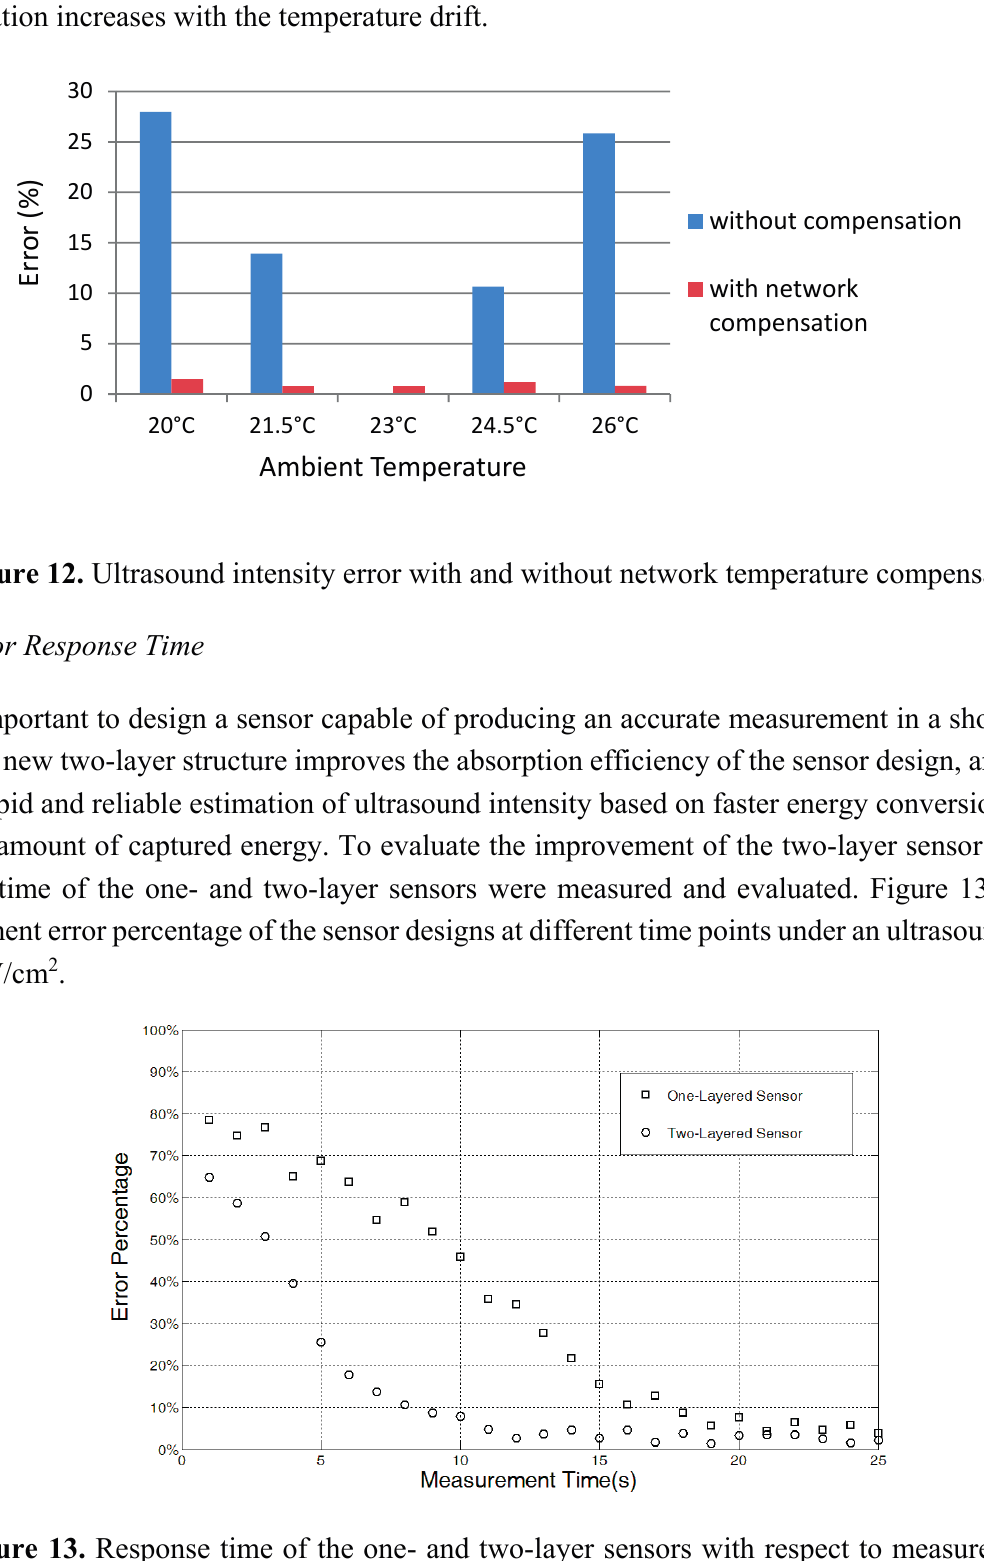
Figure 13. Response time of the one- and two-layer sensors with respect to measurement error